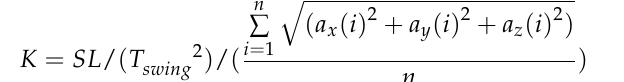
Figure 6. Experimental site. ( a ) The stadium of the Beihang Shahe Campus; ( b ) The central platform